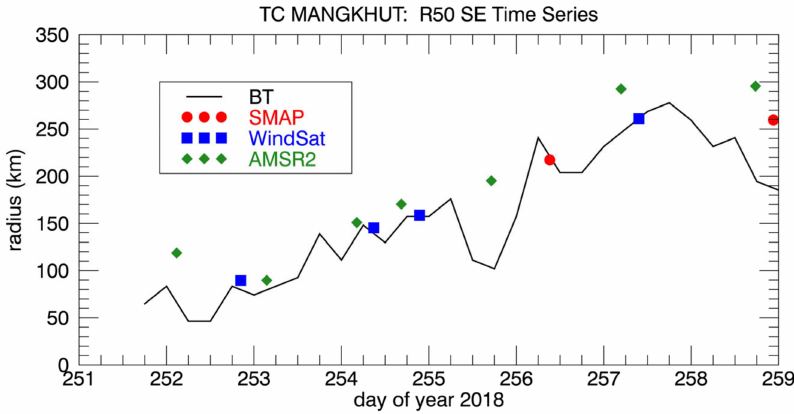
Figure 11. Time series of R50 (50 kt, 25.7 m/s, storm-force winds) in the SE sector from SMAP (red circles), AMSR2 (green diamonds) and WindSat (blue squares) passes over Super Typhoon Mangkhut in 2018. The black line indicates the R50 radii time series of the BT